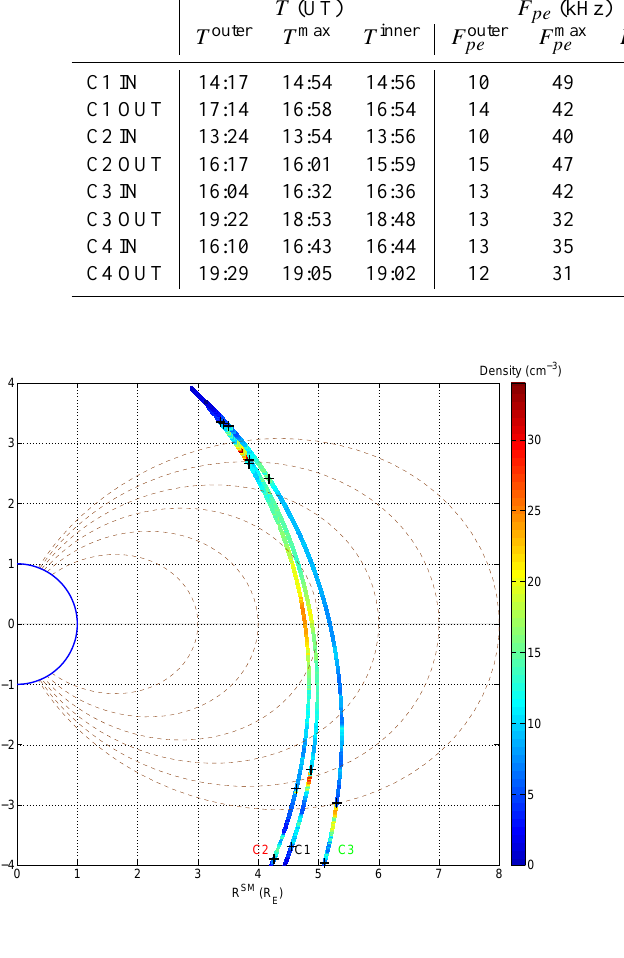
Fig. 5. Electron density plotted along the trajectories of C1, C2, C3 and C4 projected along the magnetic field lines onto the equato- rial plane in a co-rotating geocentric solar magnetospheric (GSM) frame of reference (chosen such that C4 was at 15:30MLT at 18:00UT), during the plasmasphere pass on 18 July 2005. The den- sity is plotted with the color scale on the right. The crosses show the times of the plume crossings T inner and T outer indicated in Table